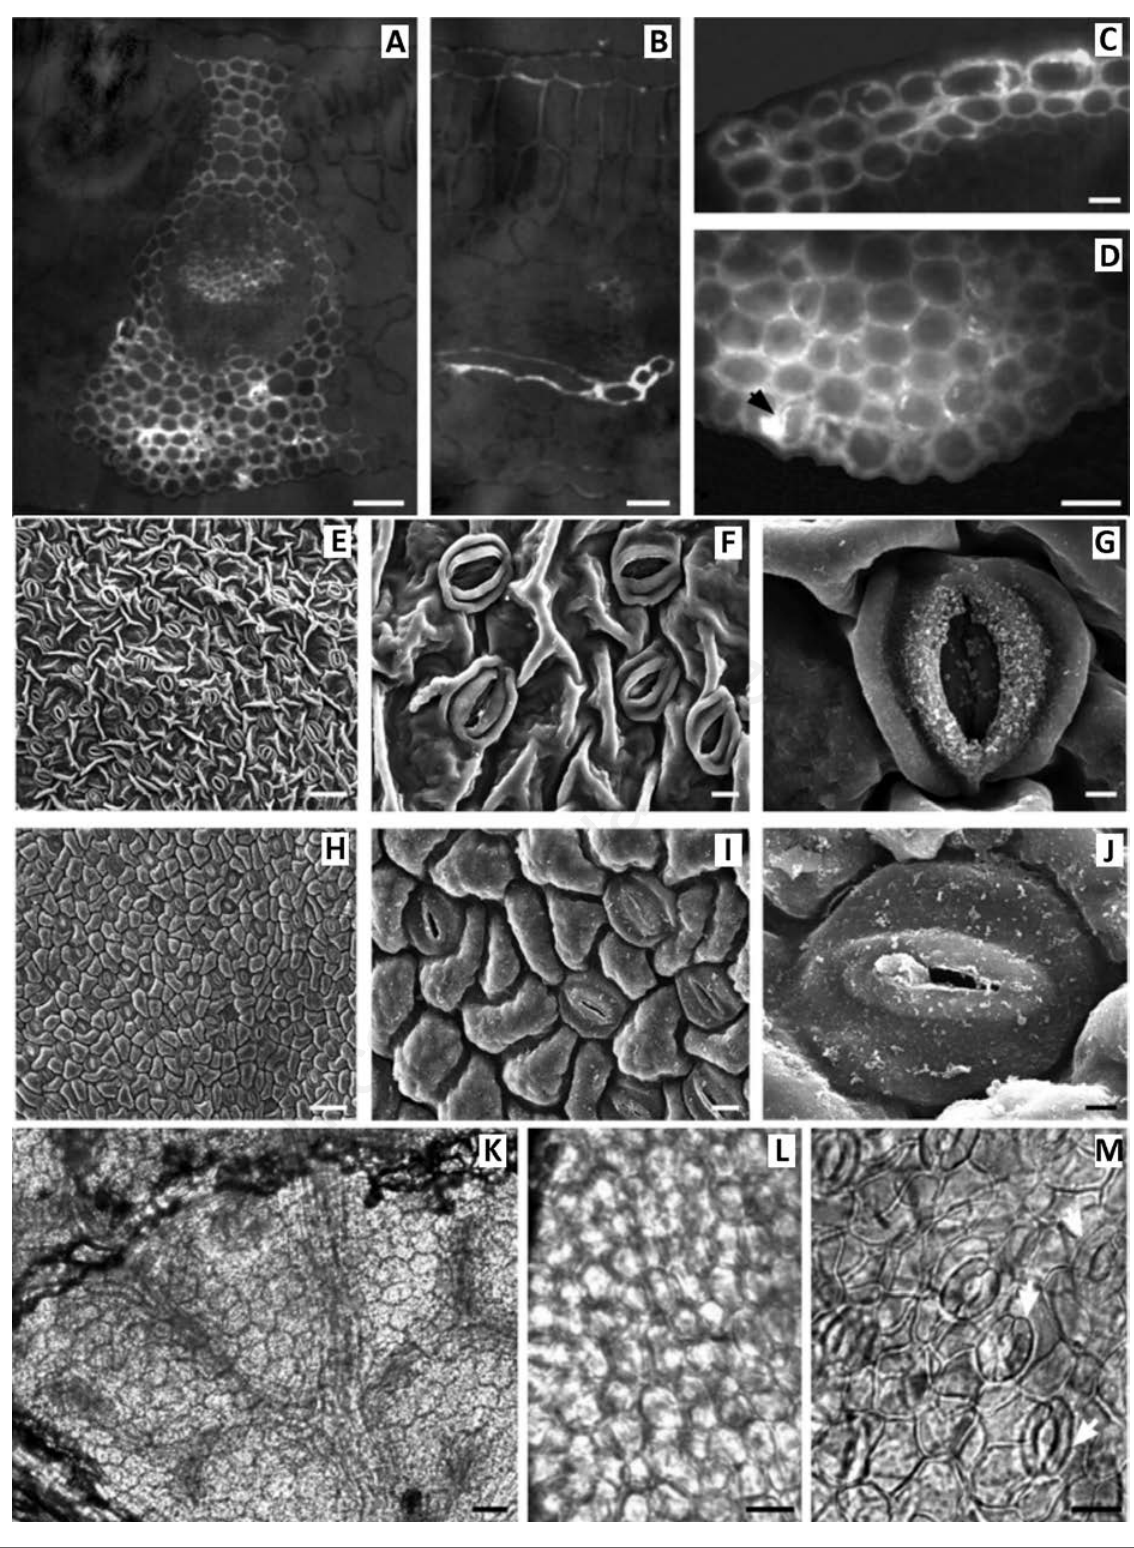
Figure 3. A-D) Micrograph of cross-section of Berberis microphylla leaves observed by UV filter BP 340-380. A) View of central vascular bundle and parenchyma cells with fluorescence; B) transversal vascular bundle with fluorescence; C) epidermal and sclerenchyma cells on the leaf apex with fluorescence; D) detail of stomata (arrowhead) and laticifer-idioblast cells. Bars: A-B, 10 µm; C, 25 µm; D, 5 µm. E-J) SEM micrograph of abaxial epidermis of Berberis microphylla leaves collected on Moreno (E-G) and Ushuaia site (H-J). E,H) General view; F,I) detail of surface of abaxial epidermis tissue; G,J) stomata detail. Bars: E,H, 50 µm; F,I, 10 µm; G,J, 5000 nm. K-M) Micrograph of diaphanized Berberis microphylla leaves. K, leaf venation; L, Detail of adaxial epidermal cells; L, Detail of abaxial epi- dermal cells with stomata (arrows). Bars: 2